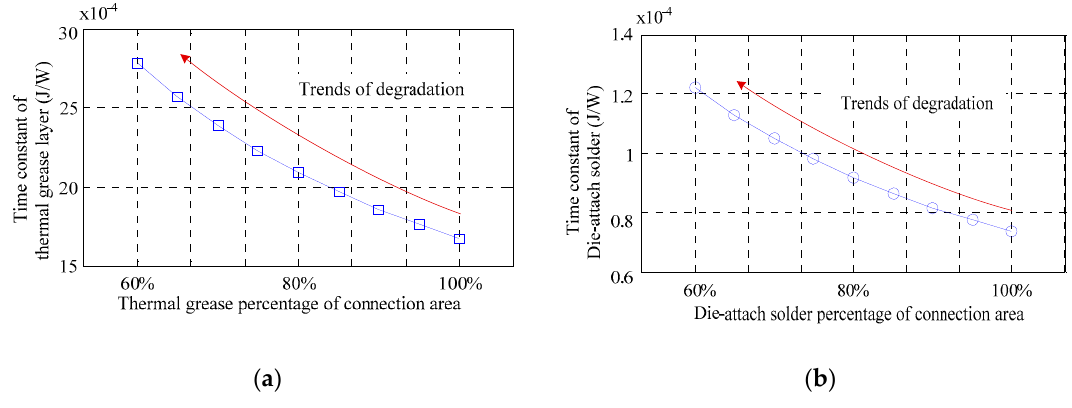
Figure 5. Thermal time constant under different connection area: ( a ) reduction of thermal grease area and ( b ) reduction of die-attach connection area.